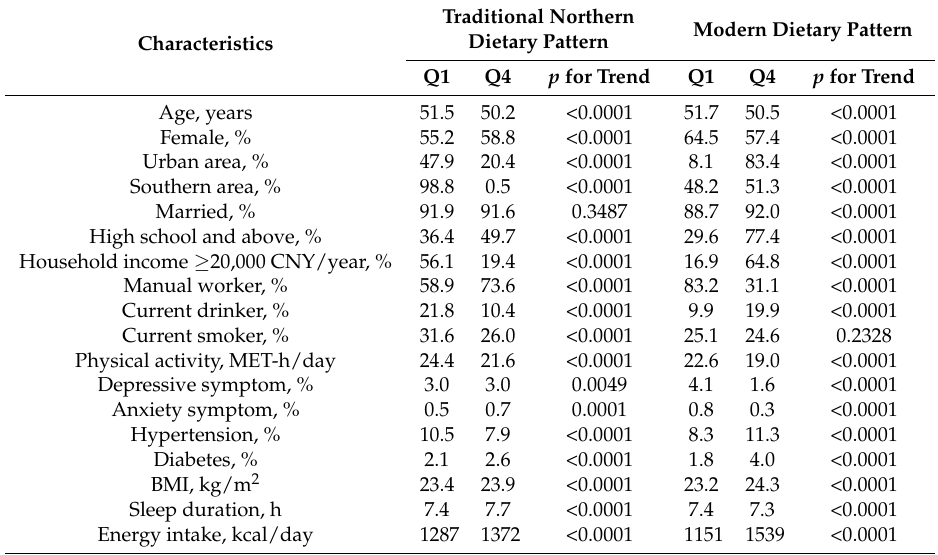
Table 2. Characteristics of participants by quartile categories of each dietary pattern score ( n = 481,424).